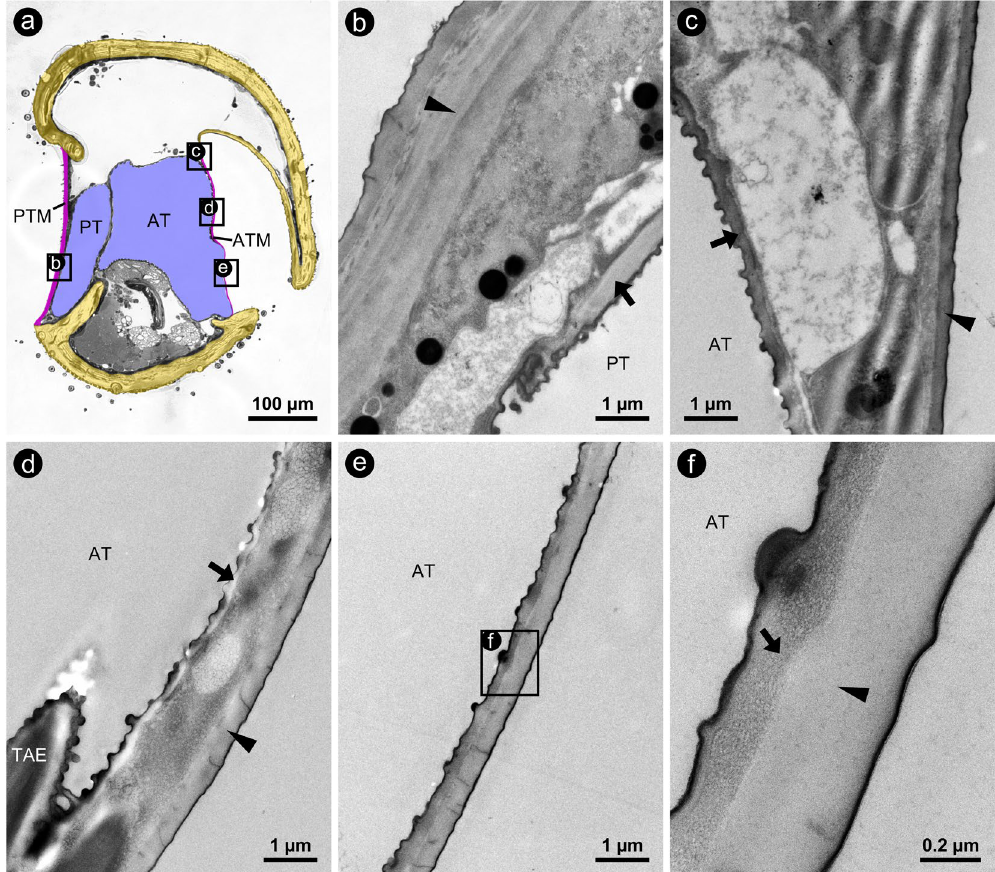
Figure 4. Micrographs of cross-sections through the proximal tibia of L . bitaeniatus . ( a ) LM-micrograph of a semithin cross-section gives an overview on the position and orientation of the following subfigures indicated by lettered rectangles. TEM-micrographs of the PTM ( b ) and of the ATM at different locations ( c–f ); positions are indicated in subfigure a. Arrows and arrowheads indicate cuticular portions of the tracheal branches and of the tympanal membranes, respectively. Orientation: top = lateral; bottom = medial; left = posterior; right = anterior. Abbreviations: AT = anterior tracheal branch; ATM = anterior tympanal membrane; PT = posterior tracheal branch; PTM = posterior tympanal membrane; TAE =